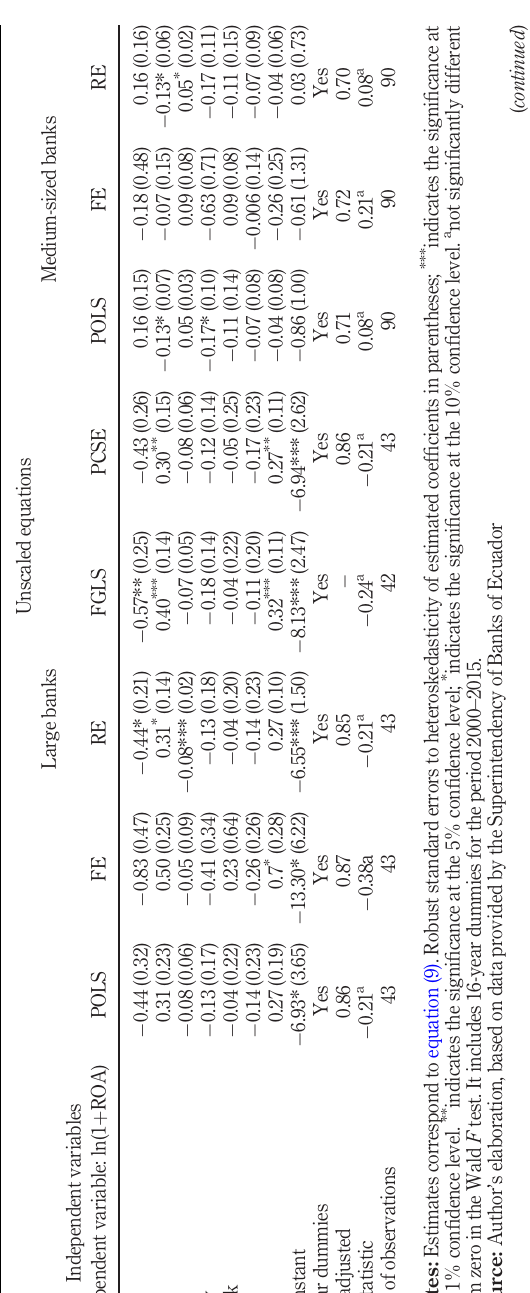
Table 7. Equilibrium